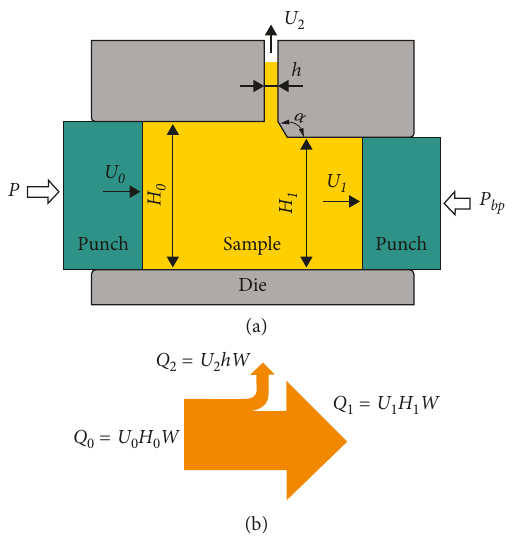
Figure 1: Schematic illustration of the PFM process: (a) die ge- ometry and (b) metal flow. P and P bp are the pressing pressure and back pressure, respectively. H 0 , H 1 , h , and α are the geometrical dimensions. W is the width dimension. U 0 , U 1 , and U 2 are the velocities, and Q 0 , Q 1 , and Q 2 are the volumes per unit time of the metal flows.